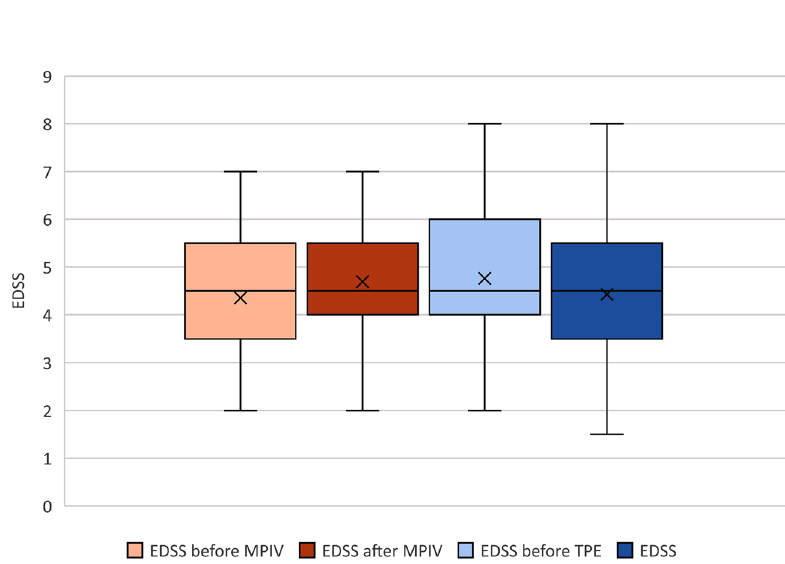
Figure 2. Changes in EDSS scores over the course of the study. Legend: Time 0–before corticosteroids, Time 1–after corticosteroids, Time 2–before TPE, Time 3–after TPE. The graph includes everyone (n = 155), but only patients who got corticosteroids contribute to times 0 and 1 (n =